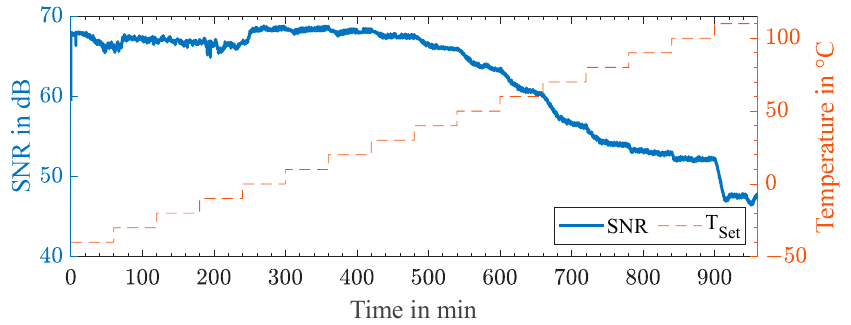
Figure 8. Signal-to-noise ratio in the measured resonance frequency shown in Figure 7. The enlarged section in the lower graph of Figure 7 shows for a time interval of 10 min the set temperature T Set of the climate chamber, the measured reference temperature T meas of the thermocouple with a resolution of 0.1 ◦ C, and an averaged value T over avg ( meas ) five samples. The accuracy of the temperature control of the climate chamber within a time interval of 30 s is indicated clearly by the data. Thus, the temperature control of the climate chamber provided no sufficiently stable temperature basis for a detailed statistical evaluation of the wireless measurement’s precision. Therefore, the temperature sensor was wirelessly measured in a thermally isolated, inactive climate chamber to investigate the precision of the wireless measurement system at a non-regulated, presumably constant temperature. The mean value µ of the resonance frequency was found to be 219,849.43 Hz with a standard deviation of 6 mHz, correspond- ing to 0.029 ppm, as shown in Figure 9. The 1600 measurement samples are shown in a histogram, together with a fitted normal distribution. The goodness-of-fit to the normal distribution was confirmed with a 0.01% significance level by a chi-square test, which further indicated a constant temperature during the sample duration.